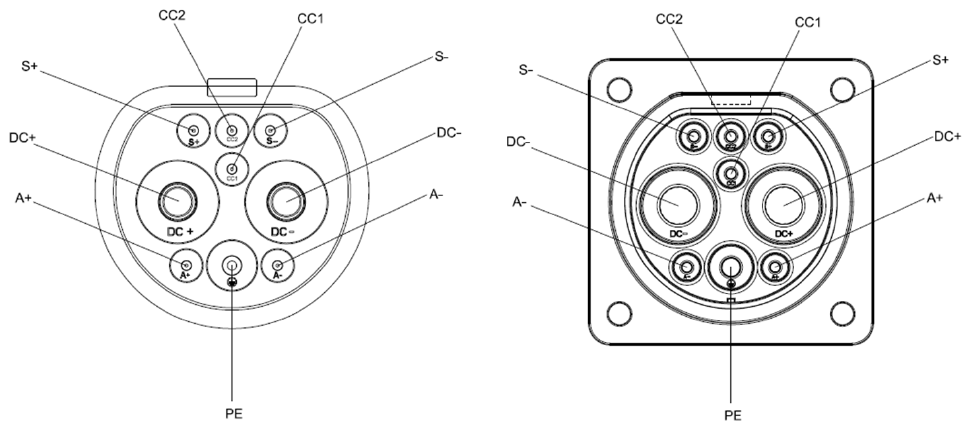
Figure 24. The GB/T DC Coupler pinout: EV Plug ( Left ) and Inlet ( Right ). Table 10. GB/T 20234 DC Coupler pins functions.